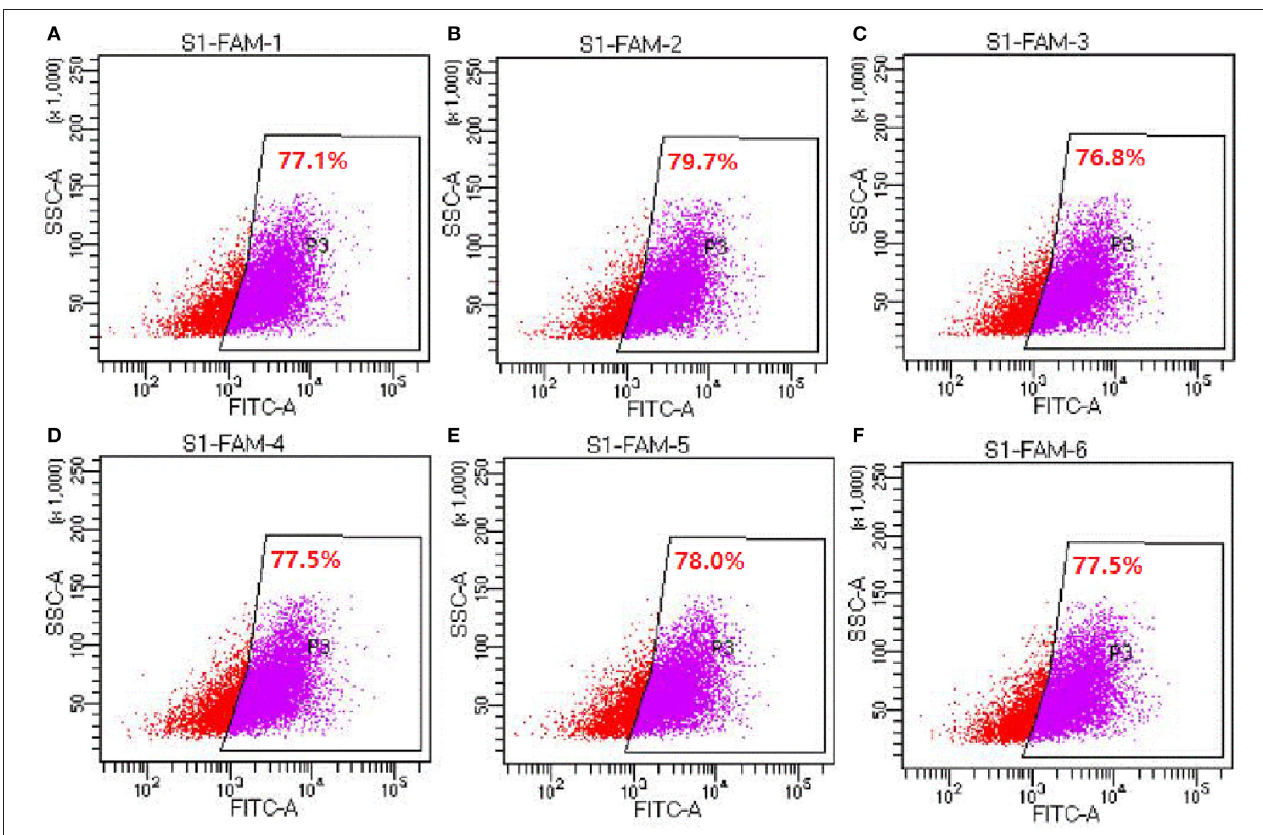
FIGURE 2 | Detection of siRNA transfection efficiency by flow cytometry (experiment 2). (A–F) Represents the six replicates, respectively, n = 6.